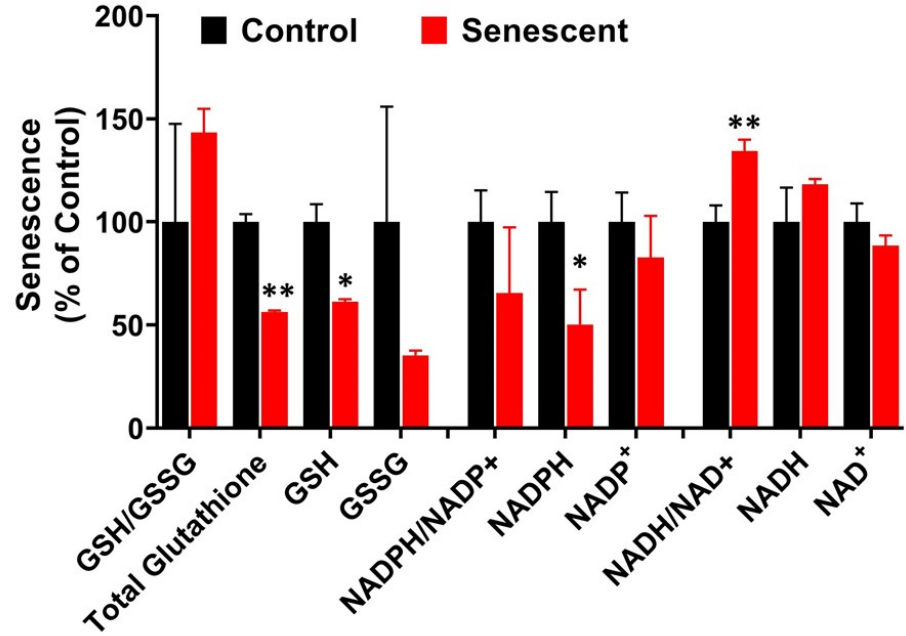
Figure 5. Levels of NAD, NADP and Glutathione metabolites in control and senescent HCT-116 cells. Metabolites in senescent cells are expressed as percent of control based on protein concentration of samples. Results are ± SD of triplicate samples. * p value < 0.05; ** p value < 0.01. Actual values obtained from analysis (nmoles/g protein) including p values and significance is presented in Table S2.